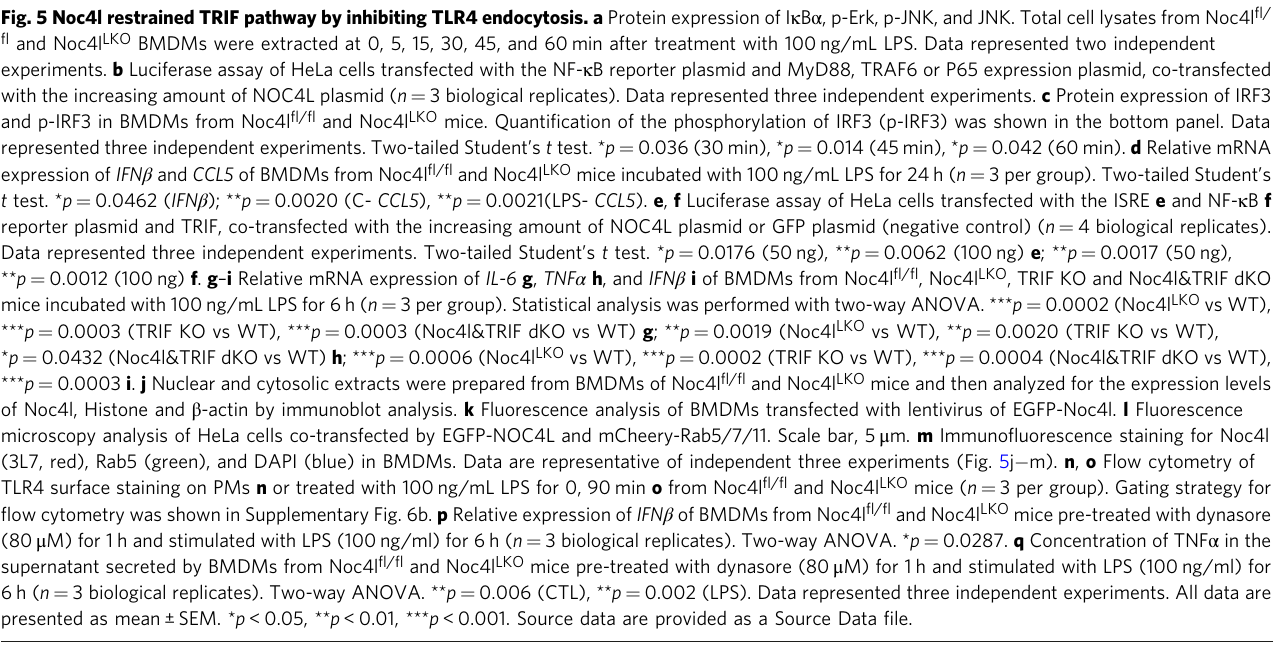
Fig. 5 Noc4l restrained TRIF pathway by inhibiting TLR4 endocytosis. a Protein expression of I κ B α , p-Erk, p-JNK, and JNK. Total cell lysates from Noc4l fl / fl and Noc4l LKO BMDMs were extracted at 0, 5, 15, 30, 45, and 60 min after treatment with 100 ng/mL LPS. Data represented two independent experiments. b Luciferase assay of HeLa cells transfected with the NF- κ B reporter plasmid and MyD88, TRAF6 or P65 expression plasmid, co-transfected with the increasing amount of NOC4L plasmid ( n = 3 biological replicates). Data represented three independent experiments. c Protein expression of IRF3 and p-IRF3 in BMDMs from Noc4l fl / fl and Noc4l LKO mice. Quanti fi cation of the phosphorylation of IRF3 (p-IRF3) was shown in the bottom panel. Data represented three independent experiments. Two-tailed Student ’ s t test. * p = 0.036 (30 min), * p = 0.014 (45 min), * p = 0.042 (60 min). d Relative mRNA expression of IFN β and CCL5 of BMDMs from Noc4l fl / fl and Noc4l LKO mice incubated with 100 ng/mL LPS for 24 h ( n = 3 per group). Two-tailed Student ’